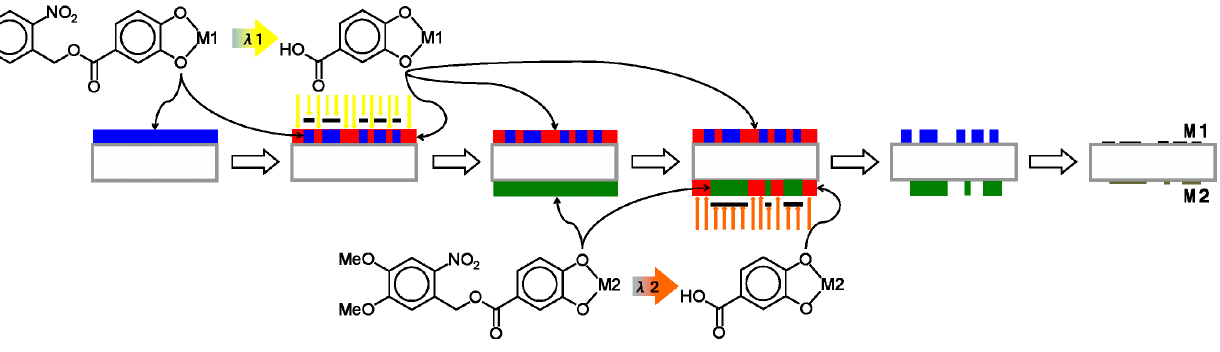
Figure 7. Procedure (Method A) for simultaneous photo patterning of independent metal/metal oxide bi-layer films using two-tone photoacid generating nitrobenzyl ester derived complexes.